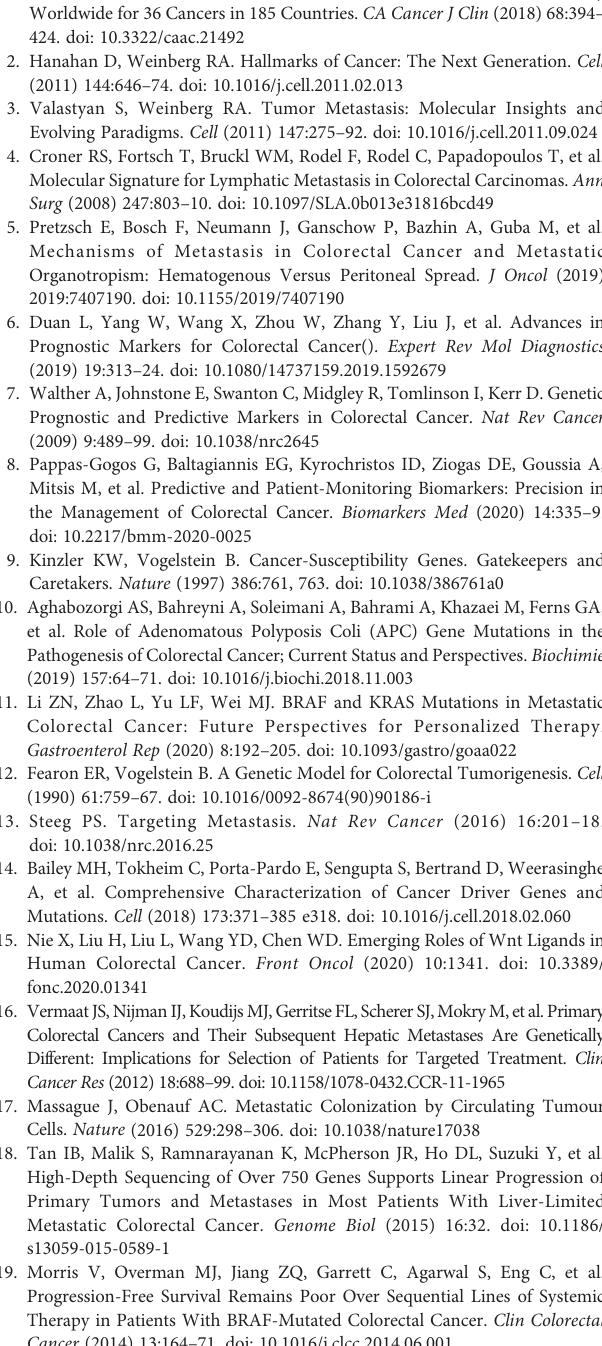
Supplementary Figure5 | The numbers of the somatic mutations of each patient in the Non-OM and OM groups of this study (A) and TCGA cohort (B) . Supplementary Figure 6 | The interaction of TMB and MS status in this study.